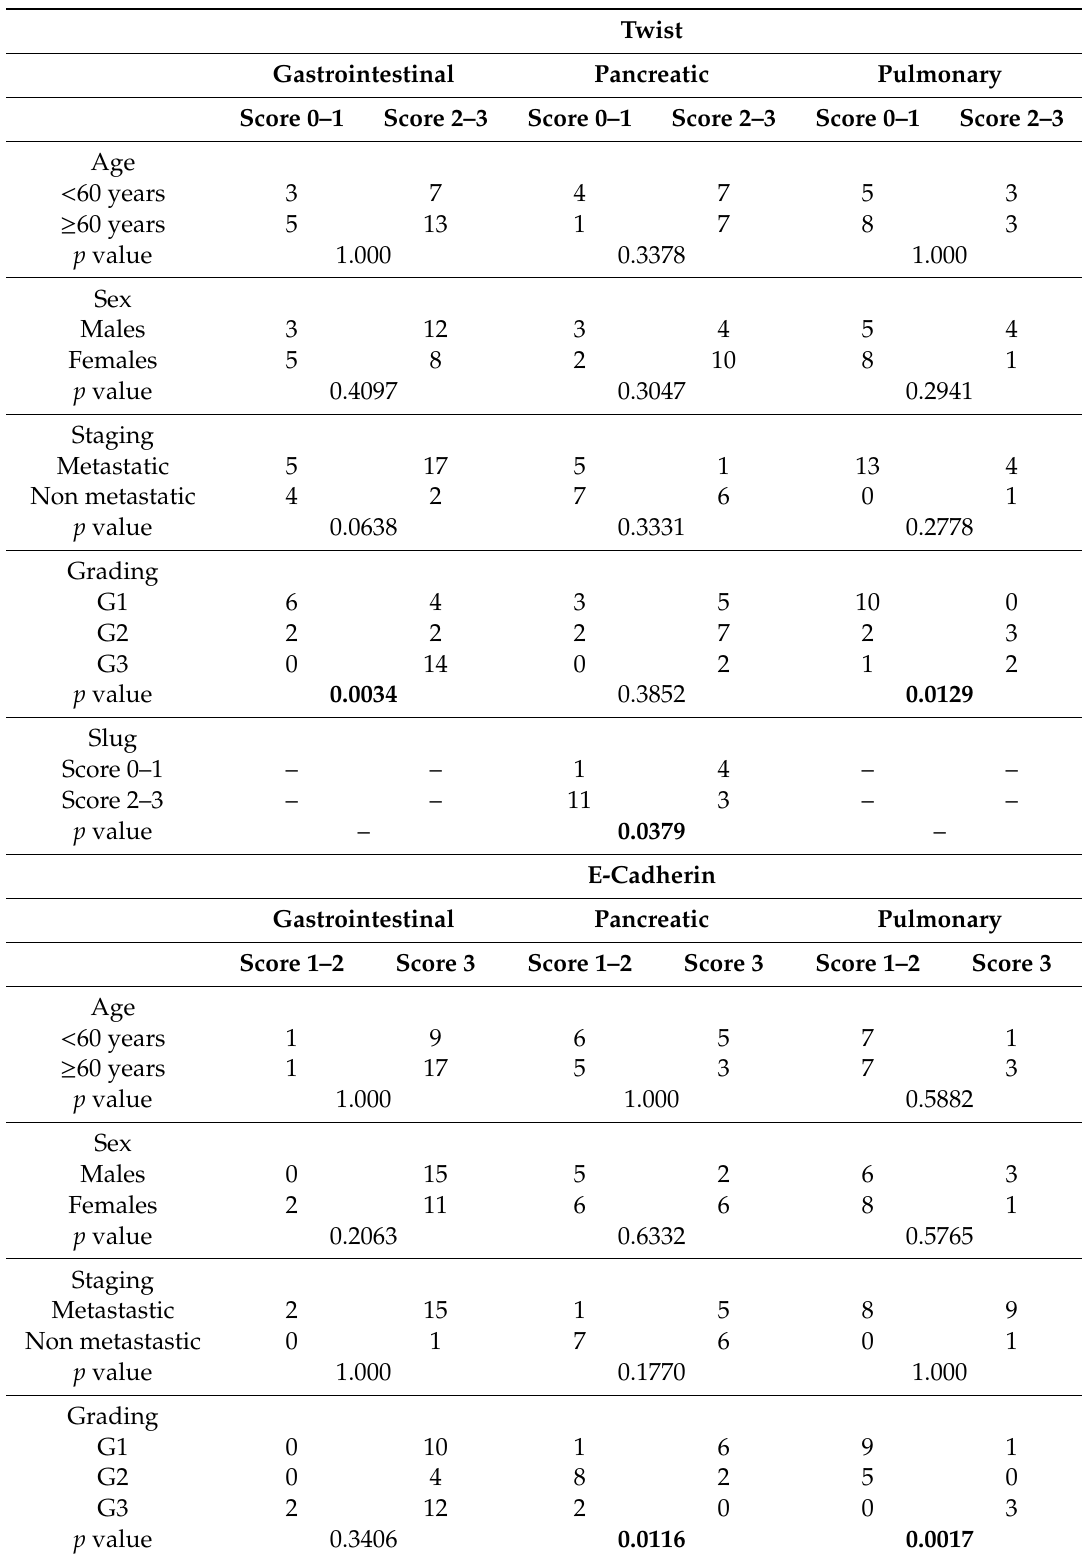
Table 4. Statistical analyses using the Fisher’s exact